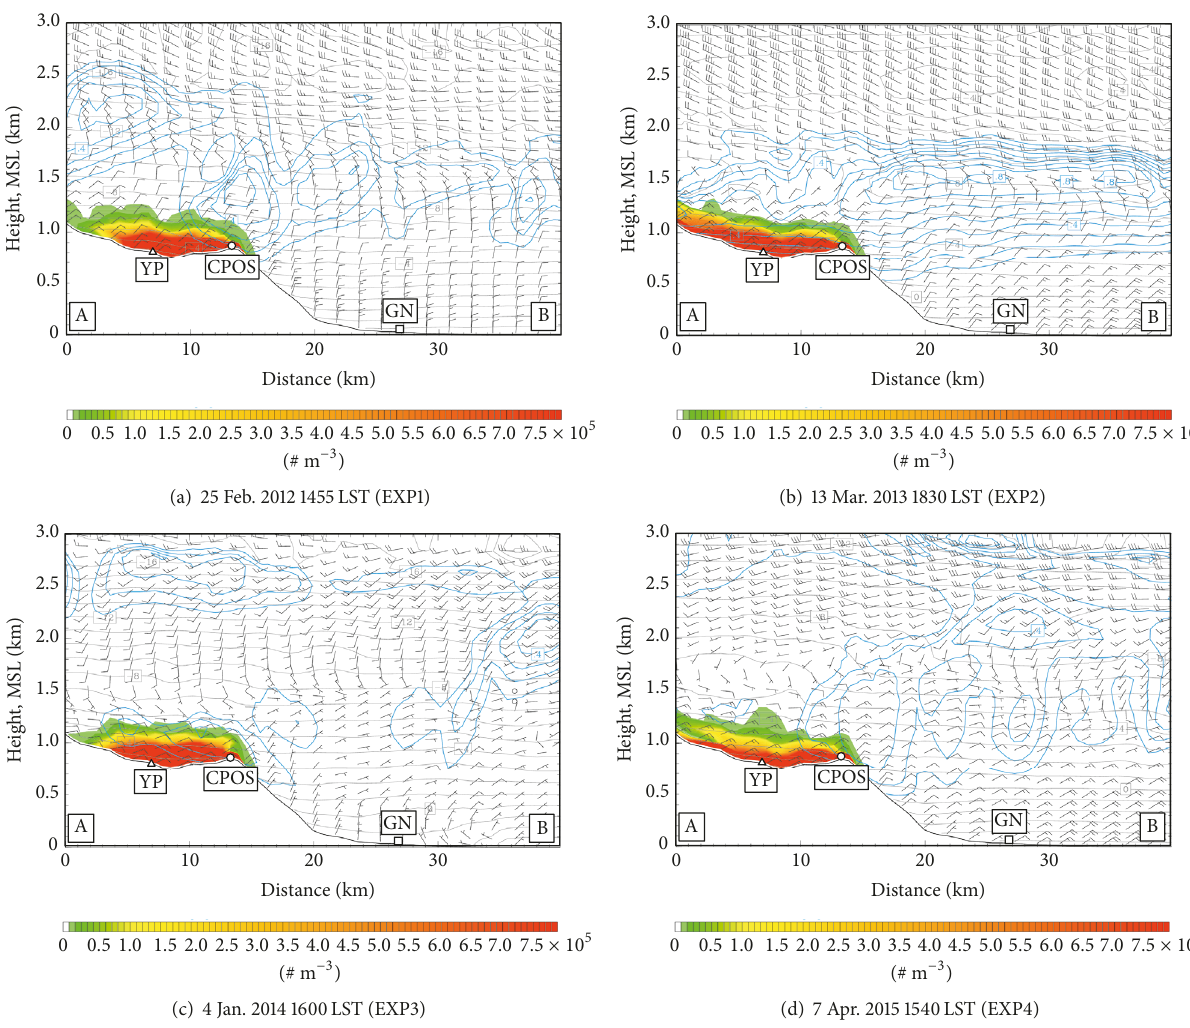
Figure 4: Vertical cross sections of the AgI particle number concentration (color shaded, m −3 ), cloud water mixing ratio (blue solid line, g kg −1 ), temperature (grey solid line, ∘ C), and wind vectors at 30min after seeding simulated by the WRF model. The A-B line is the same as shown in Figure